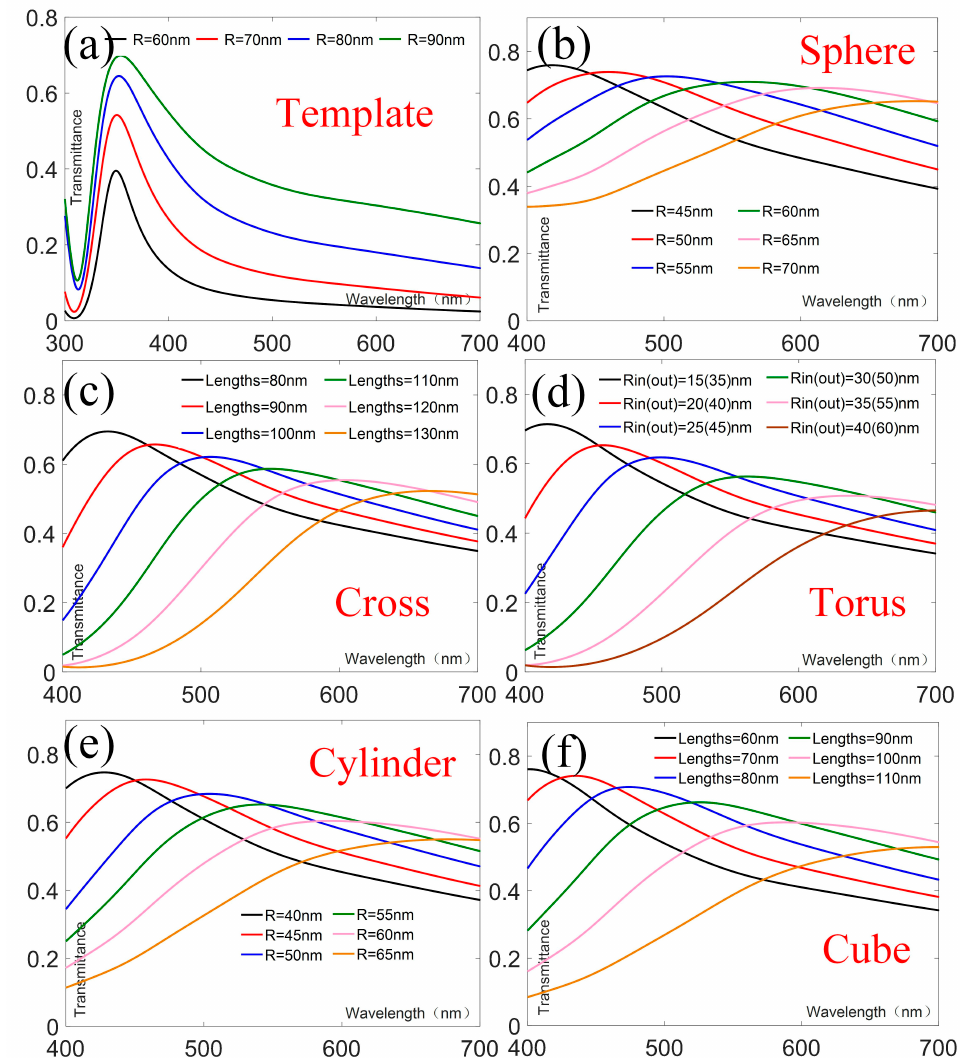
Figure 2. Transmittances of the template and different nanoparticles. ( a ) Template; ( b ) Sphere; ( c ) Cross; ( d ) Torus; ( e ) Cylinder; ( f ) Cube.